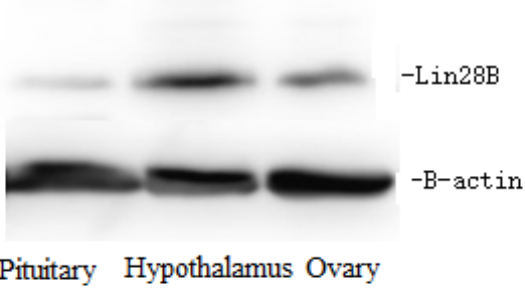
Figure 6. LIN28B protein expression in hypothalamus, pituitary and ovary of preubertal sheep. LIN28B, lin-28 homolog